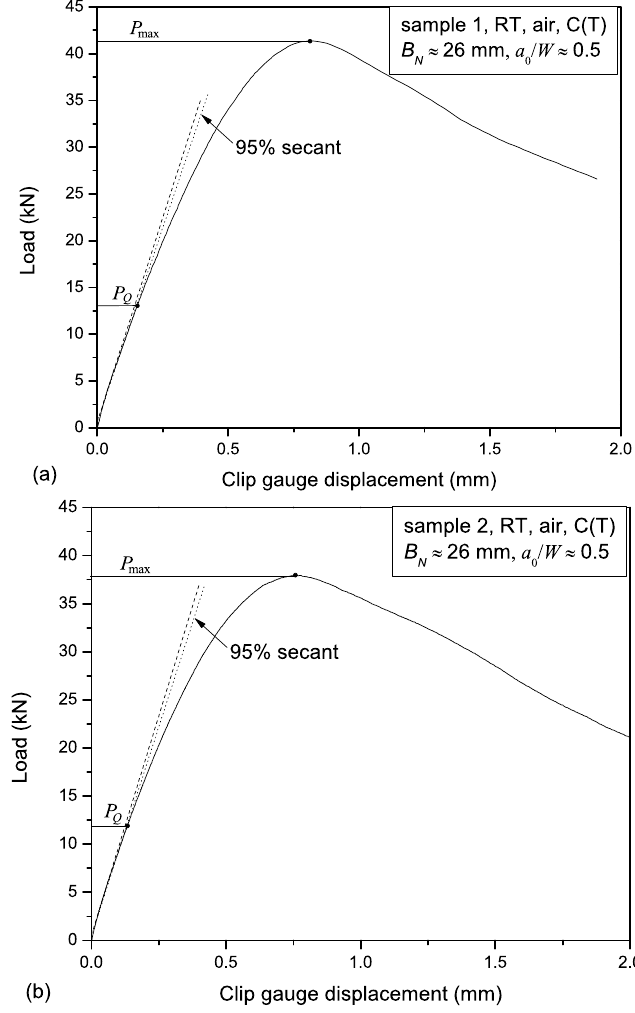
Figure 10. Load versus crack mouth opening displacement recorded for: specimen 1 ( a ); and specimen 2 ( b ) used in fracture toughness testing.